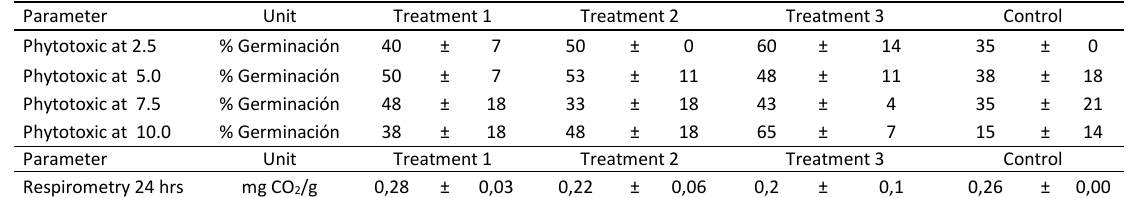
Table 5: Phytotoxicity and respirometry tests to treatments